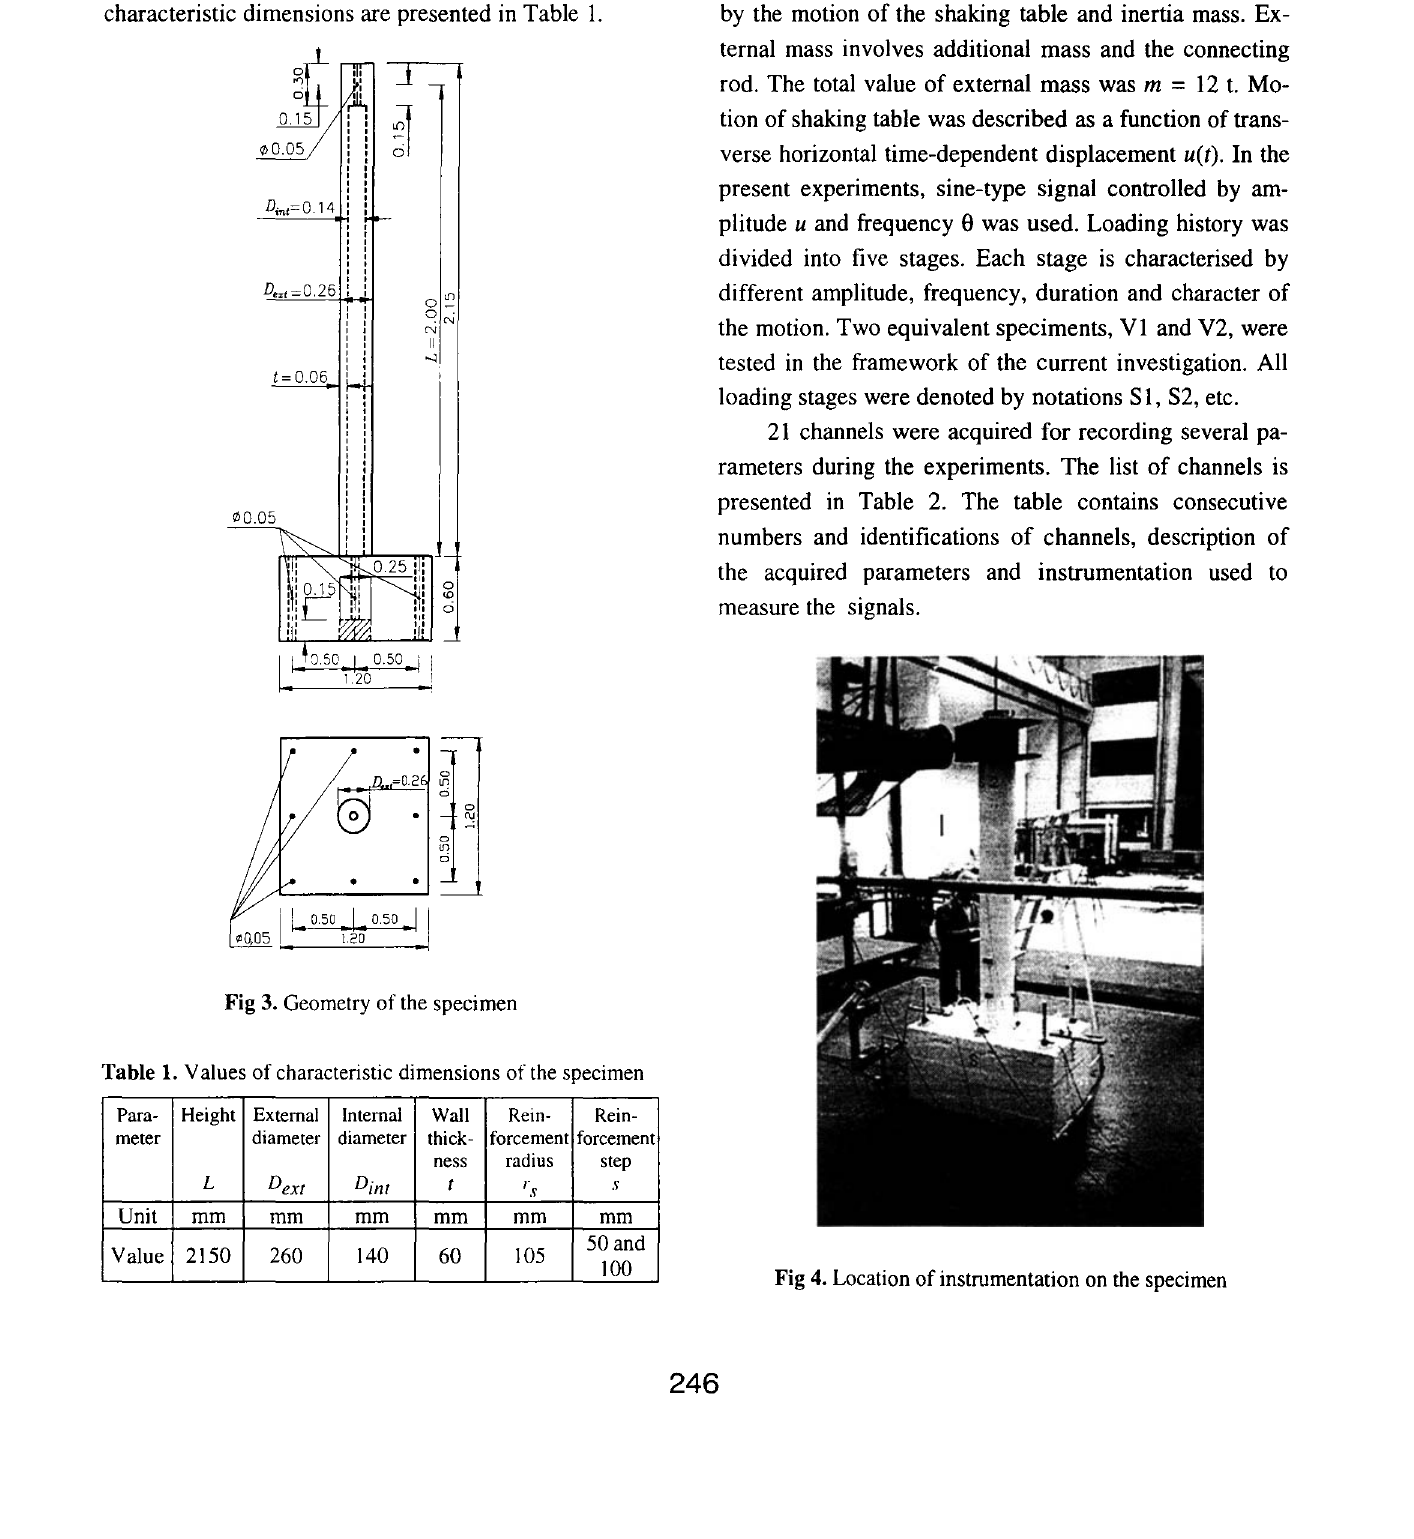
Fig 4. Location of instrumentation on the